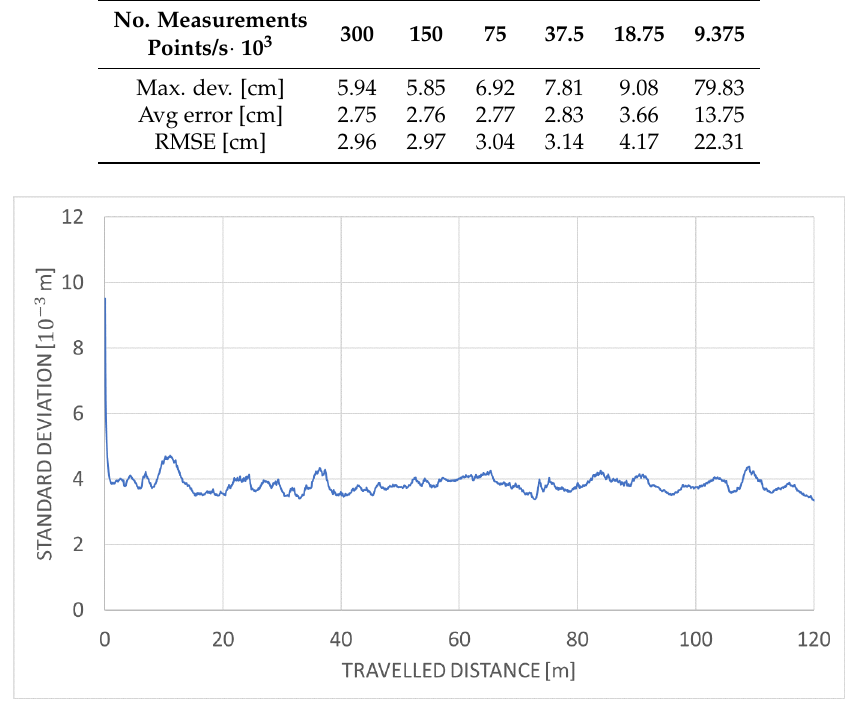
Table 4. Accuracy vs. measurement scan size for the cave dataset.